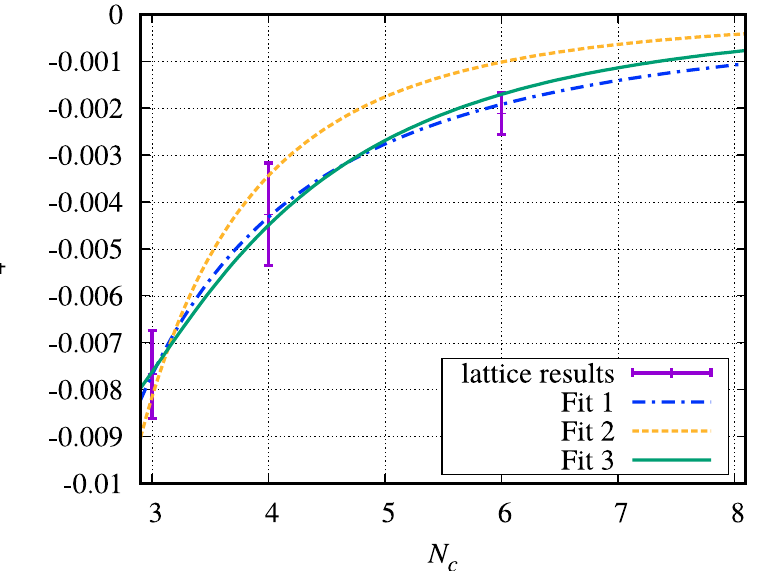
Figure 2 . Fits to the fourth cumulant measured on the lattice for di(cid:11)erent values of N c (lattice results averaged from [16, 28, 30, 44, 47, 48]). Fit 1: c 4 ( N c ) = a 6 =N 2 Fit 3: c 4 ( N c ) = (cid:0) (3( a 8 + a 9 ) 4 ) =N 3 are (cid:12)t parameters.